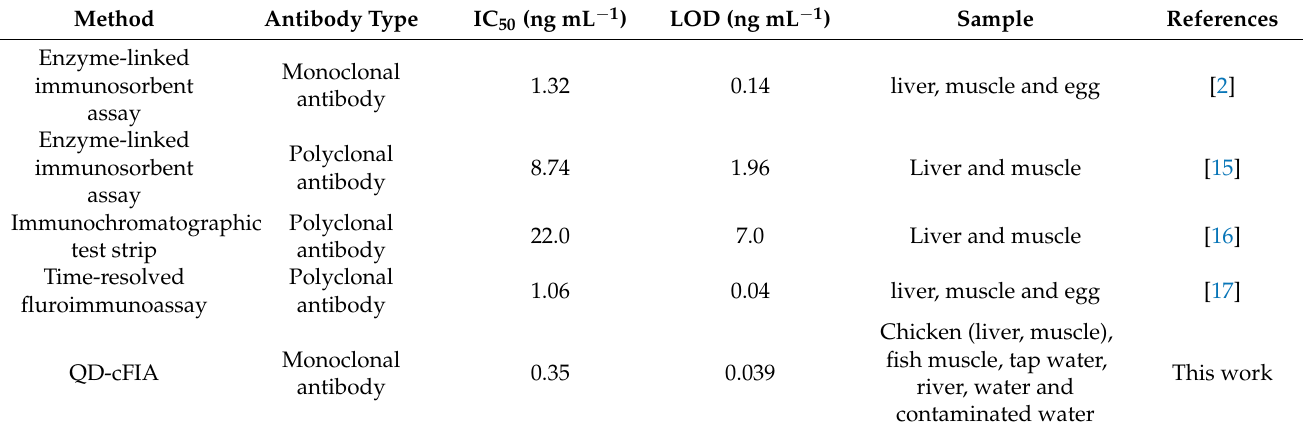
Table 1. A review of immunoassay methods for the determination of DOX in recent